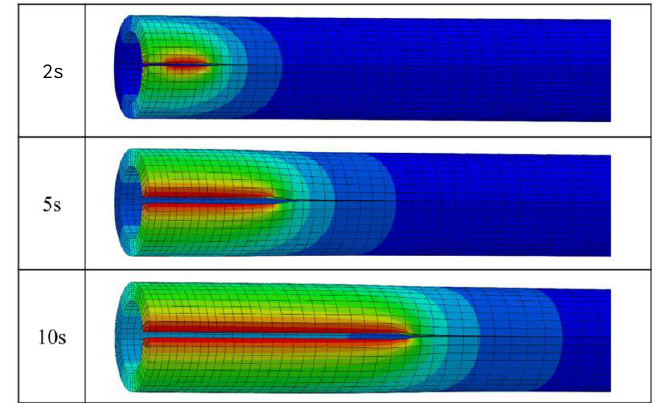
Figure 10. The damage value cloud maps of axial crack at different injection times.